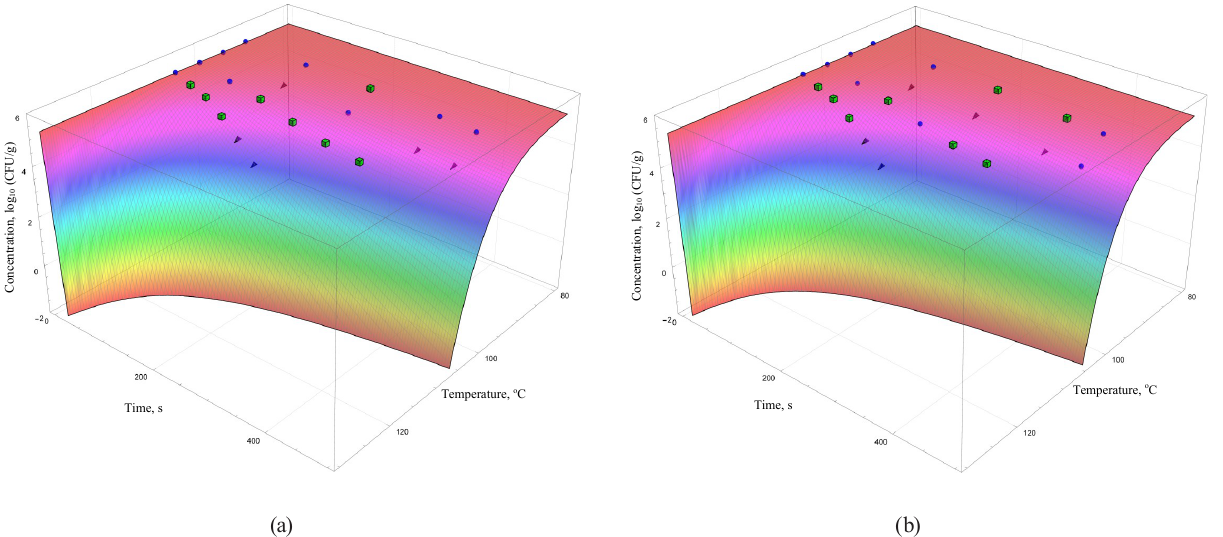
Figure 6 Secondary linear model and nonlinear model of microbial death A. acidoterrestris during heat treatment. (a) Bigelow model modified by Arrhenius, (b) Weibull model.